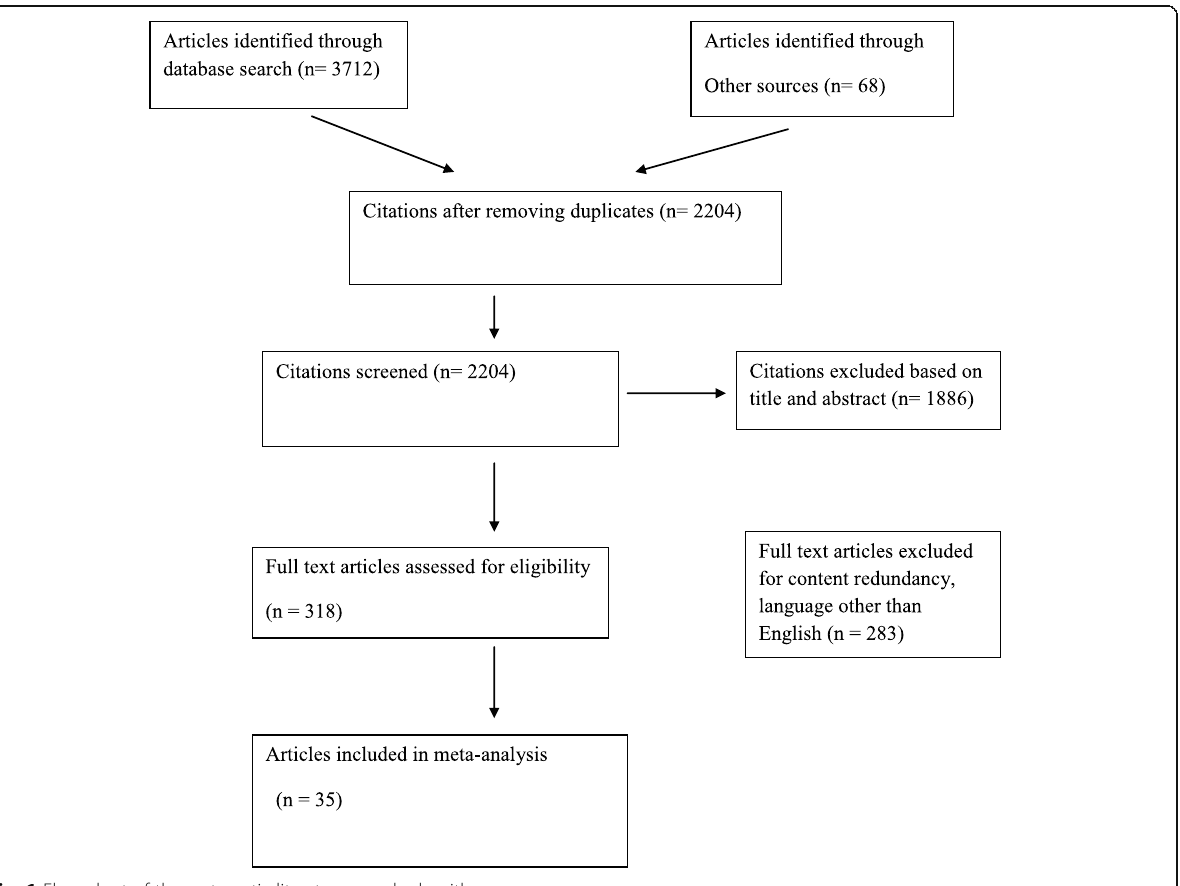
Fig. 1 Flow chart of the systematic literature search